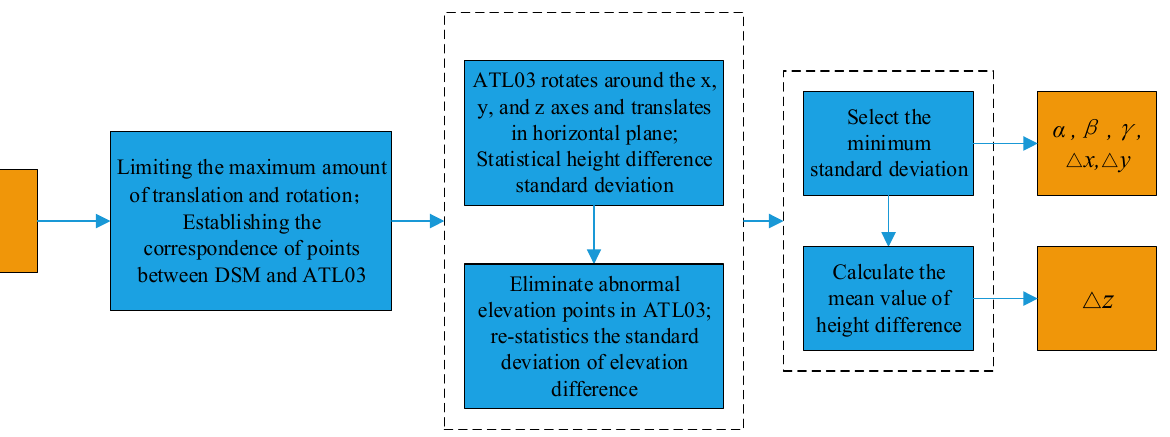
Figure 6. Algorithm flow of DSM registration based on terrain similarity (BOTS).